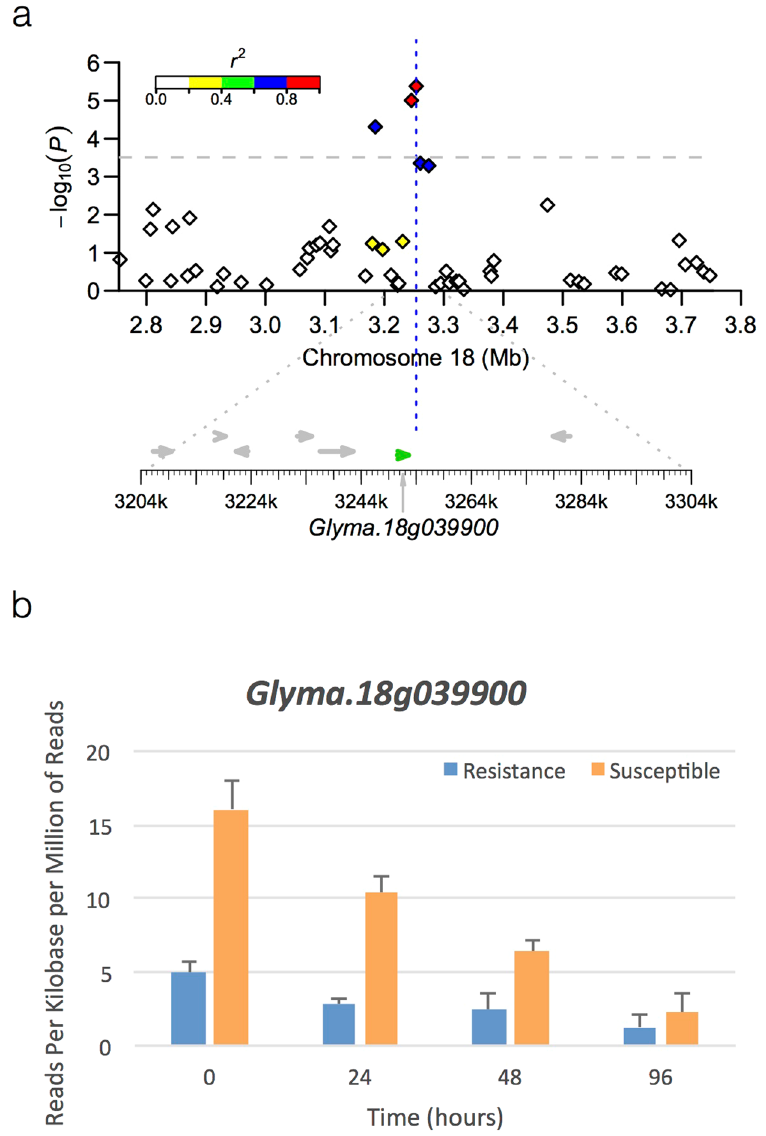
Figure 3. Regional association plot of ss715630264 associated with 15GHSE-DAI03 and expression of the candidate gene Glyma . 18g039900 . ( a ) The top panel shows the negative log10-transformed P values from a genome-wide scan by using a mixed linear model (MLM) for plant severity taken 3 DAI within the adjacent region of peak SNP ss715630264 plotted against base pair positions (Mb) on soybean chromosome 18. The significance threshold line is distinguished (gray dotted line), and each SNP depicts the extent of linkage disequilibrium in the region based on pairwise values with respect to the peak SNP. The values are indicated using the color intensity index shown. The bottom panel shows all putative genes in the region. The putative candidate gene indicated in green. ( b ) The expression of Glyma . 18g039900 , the putative candidate gene for ss715630264 , in a modern resistant (blue) and susceptible (orange) cultivar. Error bars shown to indicate significance (p <